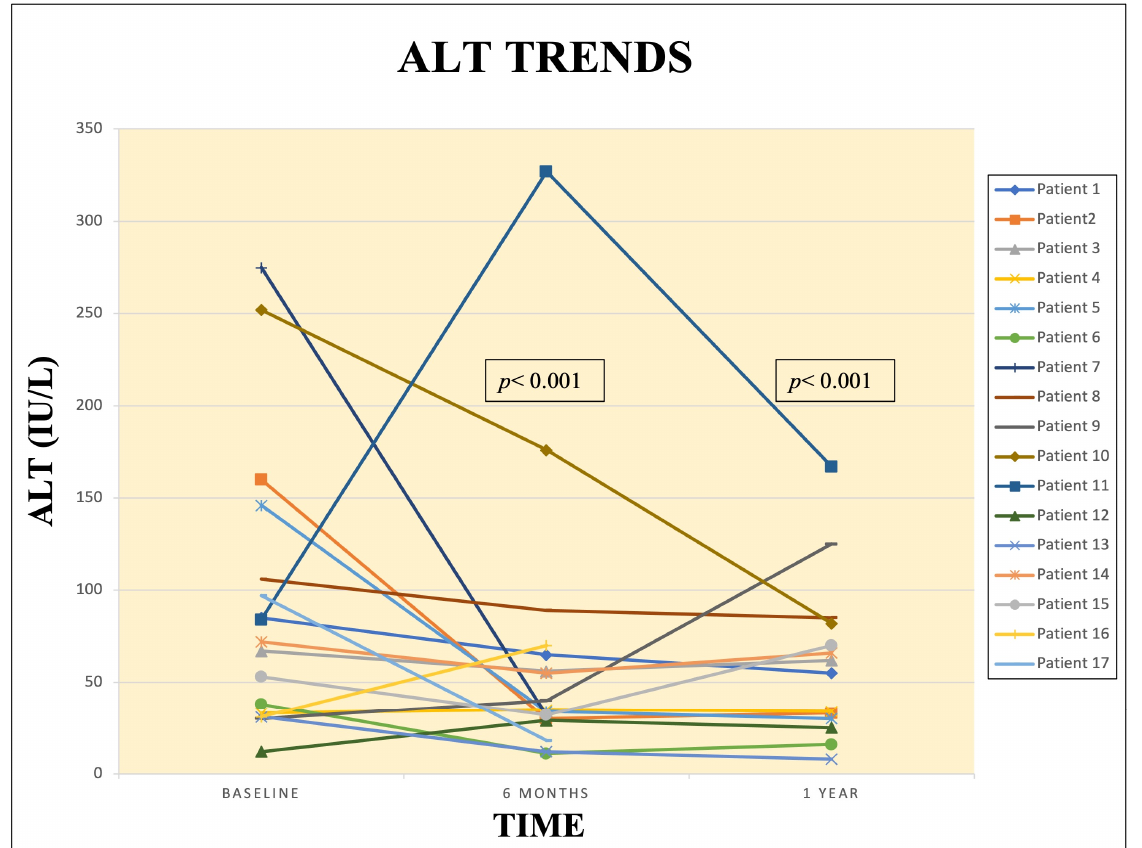
Figure 4. Alanine Transaminase (ALT) Trends at baseline, six months and one year after the initiation of Oral Vancomycin Therapy (OVT), p < 0.001.